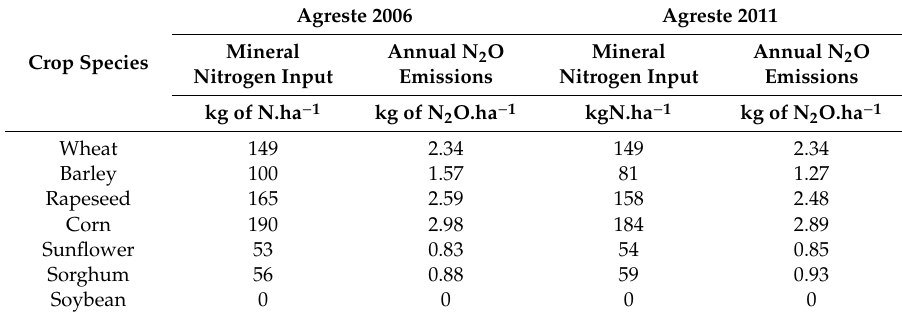
Table 1. Average of the mineral nitrogen input and of the associated potential N 2 O emissions per crop type, for the two available investigations conducted in 2006 and 2011, by the French ministry of agriculture and